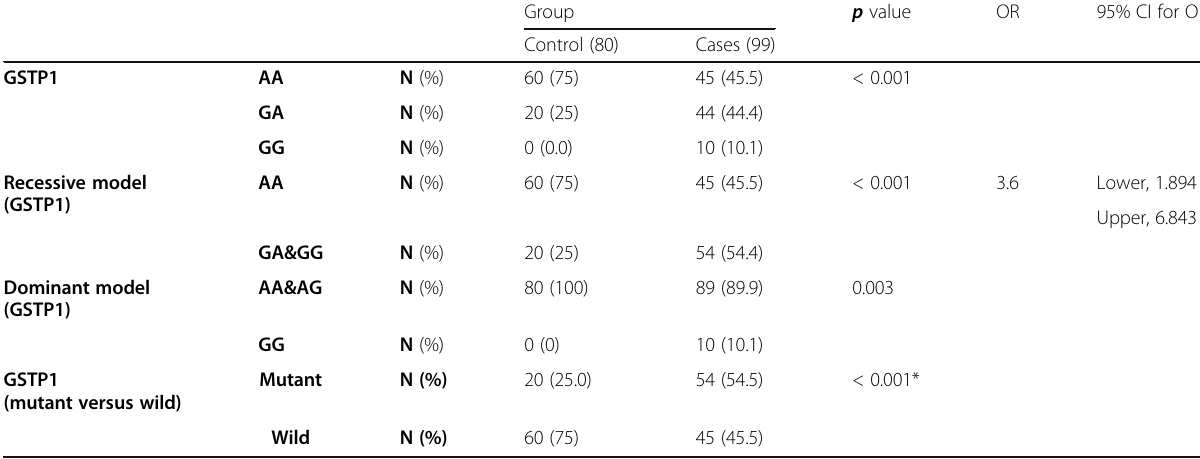
Table 2 Comparison between the HCC and the normal control groups as regards the glutathione S-transferase P1 (GSTP1)